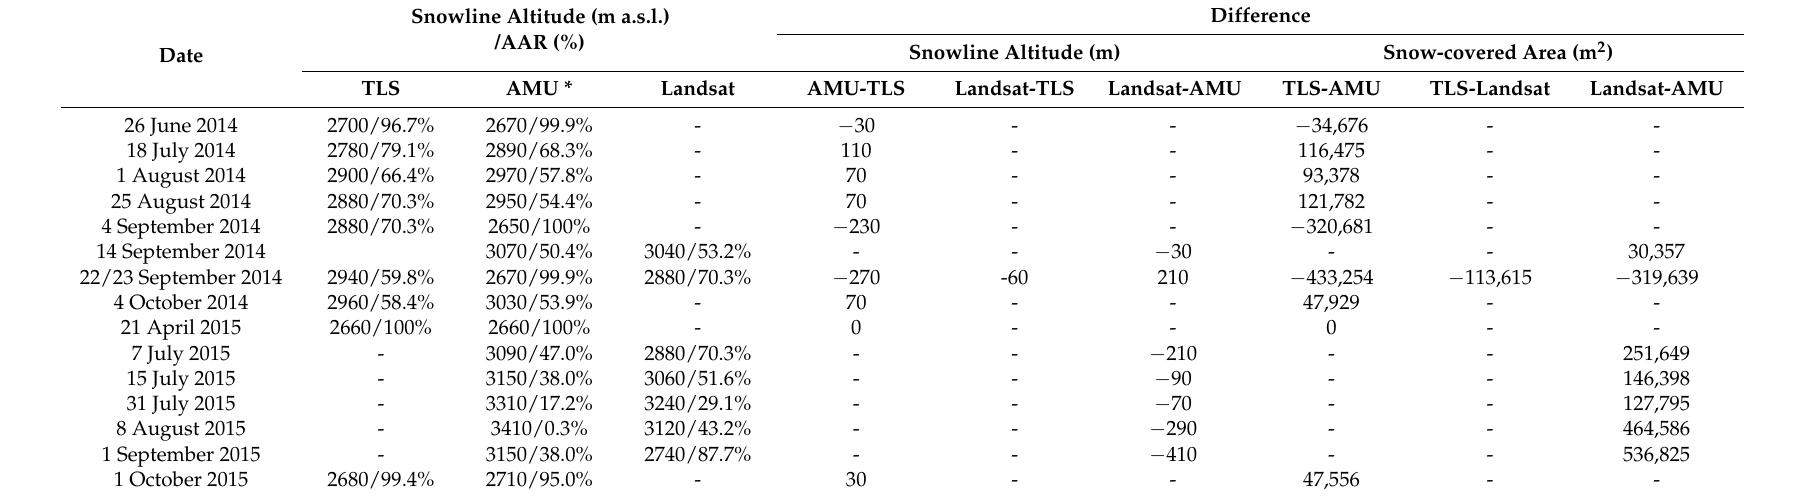
Table 6. Comparison of the transient snowline altitudes and snow-covered areas obtained using the three